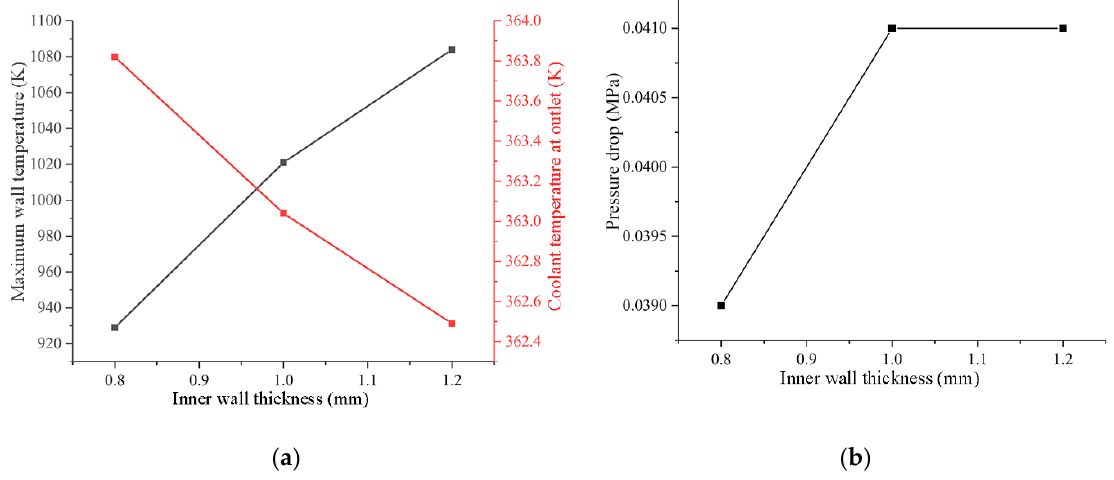
Figure 25. Temperature and pressure drop at different inner wall thickness. ( a ) Wall temperature and coolant temperature; ( b ) pressure drop at different rib heights.